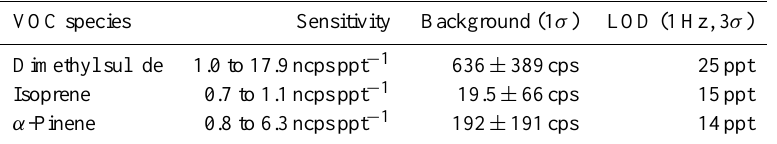
Table 1. Summary of in-field CI-ToFMS performance on the HiWinGS research cruise for select volatile organic compounds. Isoprene and α -pinene were calibrated against in-field standards. DMS figures of merit utilized simultaneous independent DMS mixing ratios from the University of Hawaii’s APIMS-ILS. Limit of detection (LOD) was calculated for 1s averaging times using normalized sensitivities corresponding to Q = 6gkg − 1 .